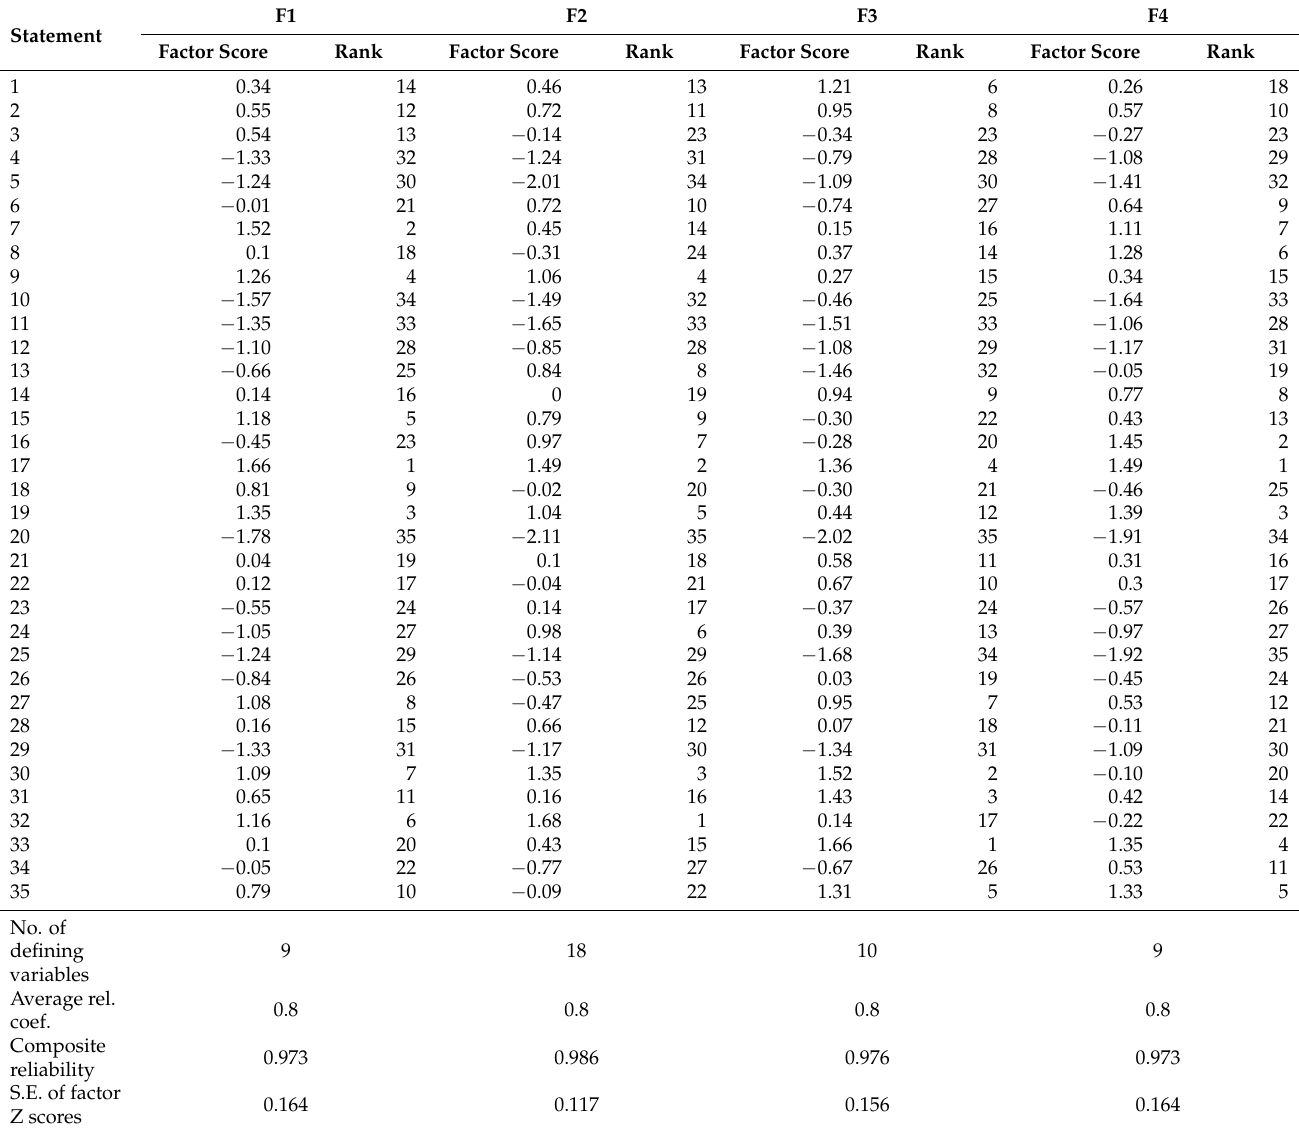
Table A2. Factor Score, Ranks * and